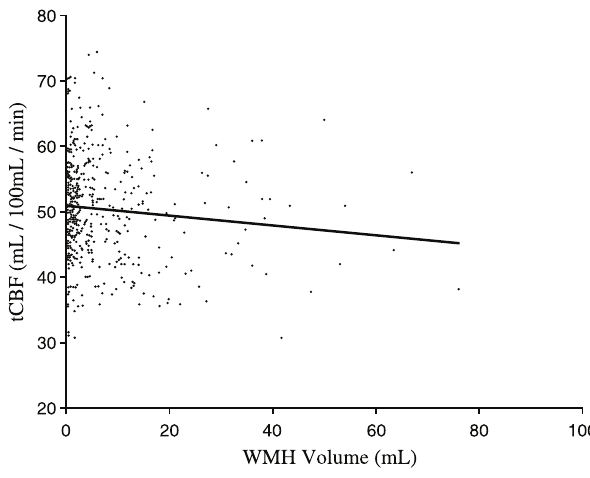
Figure 5. Association of tCBF (mL/100 mL/min) with WMH volume. Scatterplot of tCBF (mL/100 mL/min) versus WMH volume (mL).